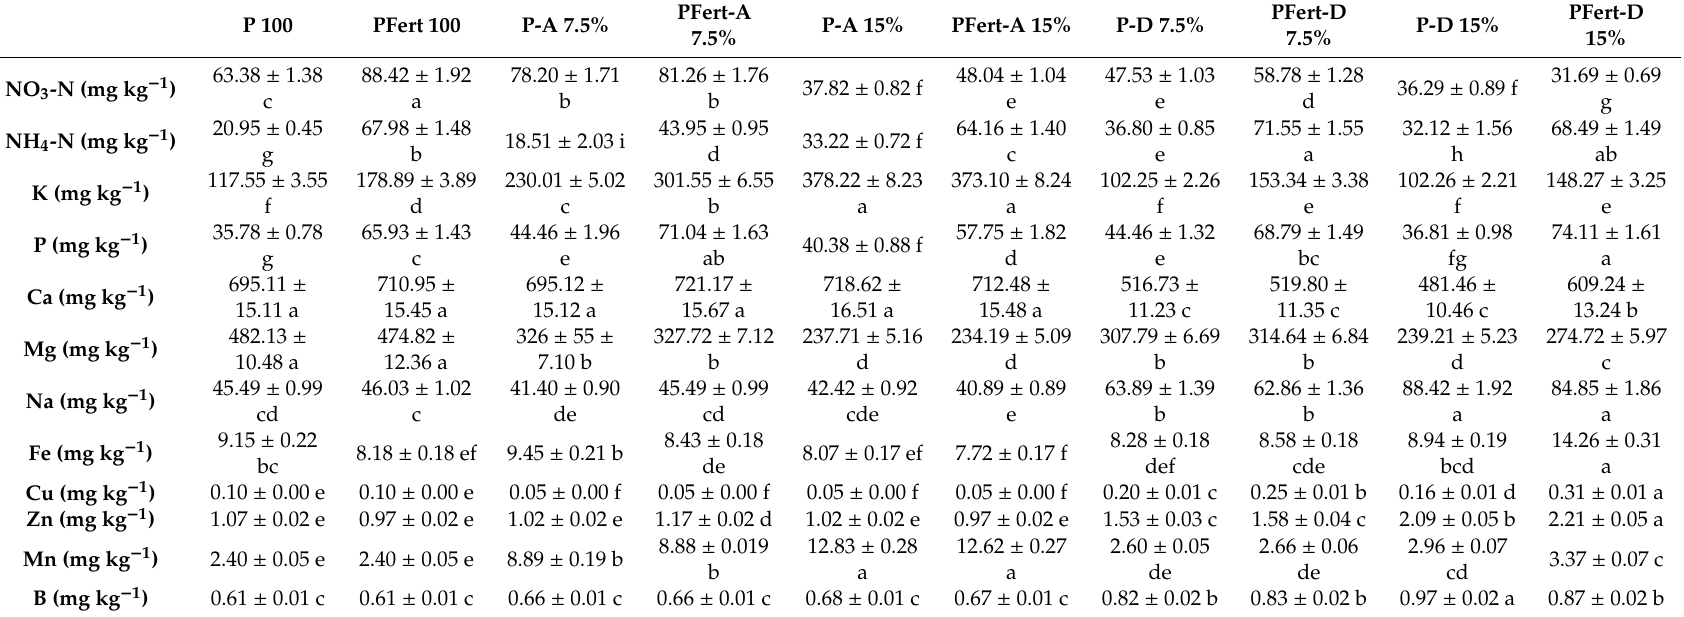
Table 2. E ff ects of peat (P 100) with di ff erent biochar types (A, D) and ratio (7.5%, 15%) and mineral doses (with standard or with additional Fertilizers-Fert.) on substrate minerals